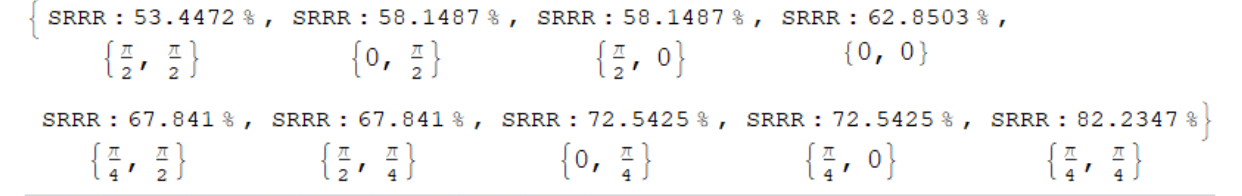
Figure 7. Solar Radiation Reception Rate for m = 2 and n = 2 at the summer solstice in the region of Makkah, Saudi Arabia.